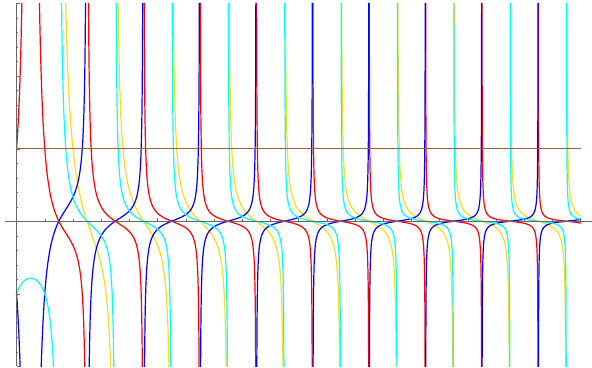
Figure 12 . The dimensions of the operator in the vector and tensor 4-point function asymptote to the same value as the dimension